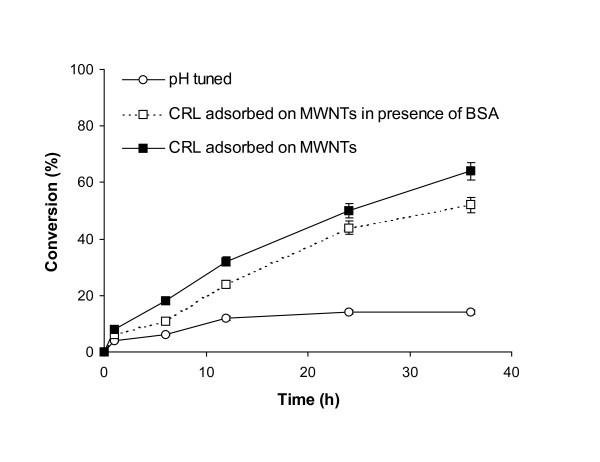
Transesterification of ethyl butyrate with butanol in hexane. Each point represents the outcome of a pair of readings.